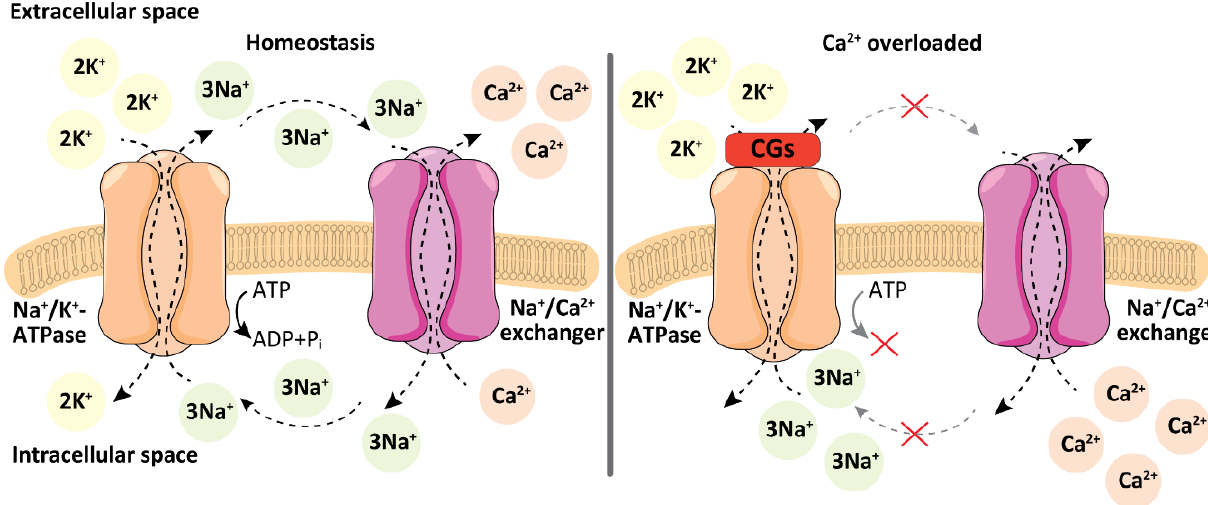
Figure 1. Physiological action of Na + /K + -ATPase and Na + /Ca 2+ exchanger compared to the action after treatment with cardiac glycosides (CGs). In homeostasis, Na + /K + -ATPase pumps three Na + ions out of a cell and two K + ions into the cell. Physiologically Na + /Ca 2+ exchanger imports three Na + ions back into the cell in exchange for one Ca 2+ ion. When the activity of Na + /K + ATPase is blocked by CGs, Na + ions accumulate inside the cell, which leads to a subsequent increase in intracellular Ca 2+ ion concentration due to activation of the Na + /Ca 2+ exchanger. Inspired and adapted according to ref. [34].